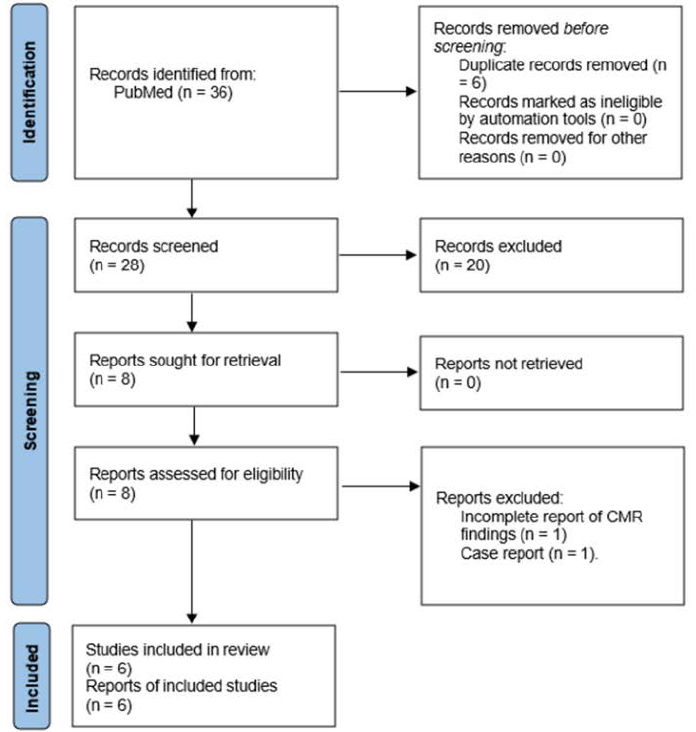
Figure 1. Prisma algorithm depicting the selection process of reviewed studies.